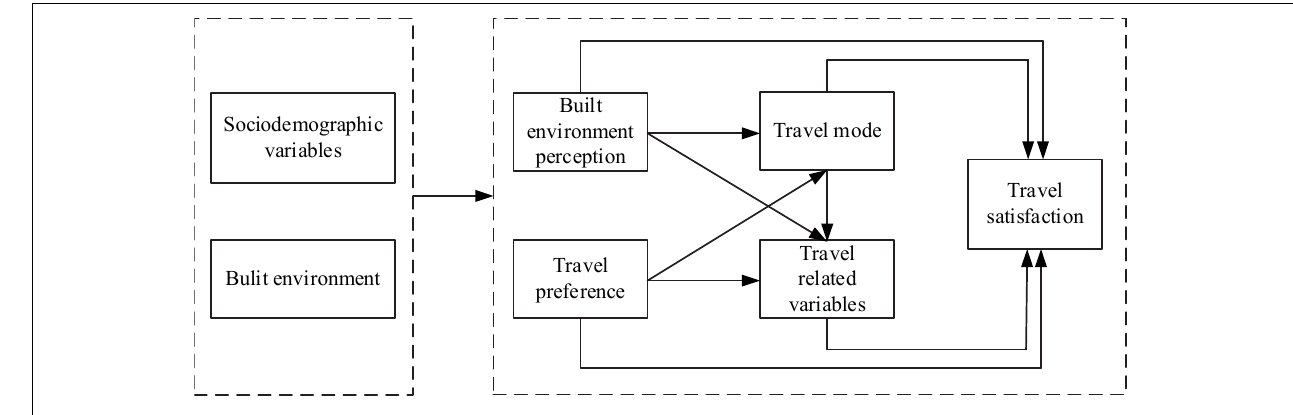
FIGURE 1 | The conceptual framework.